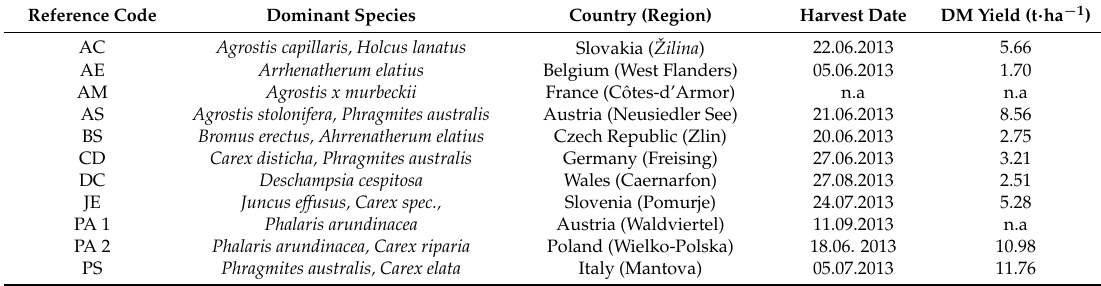
Table 1. Vegetation data for the grassland sites used for the study, along with regions, harvest date, and DM